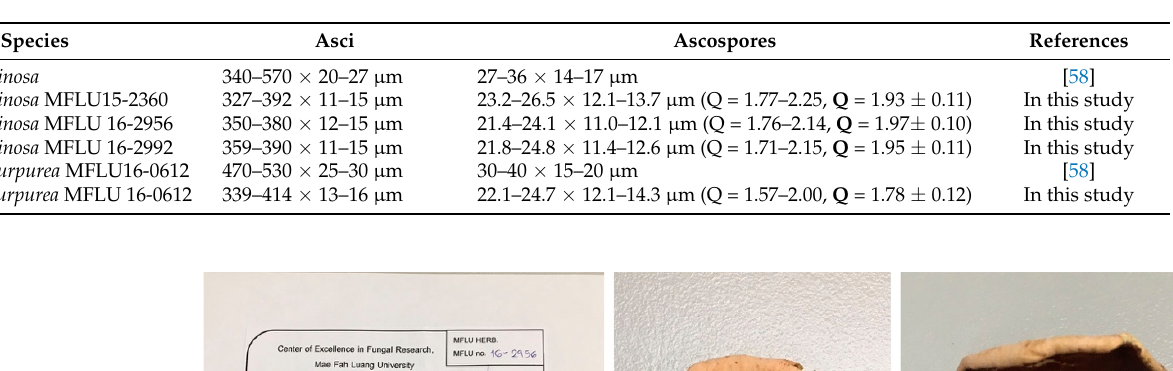
Table 3. Sizes comparison for asci and ascospores of Phillipsia gelatinosa and Phillipsia subpurpurea (MFLU16-0612).